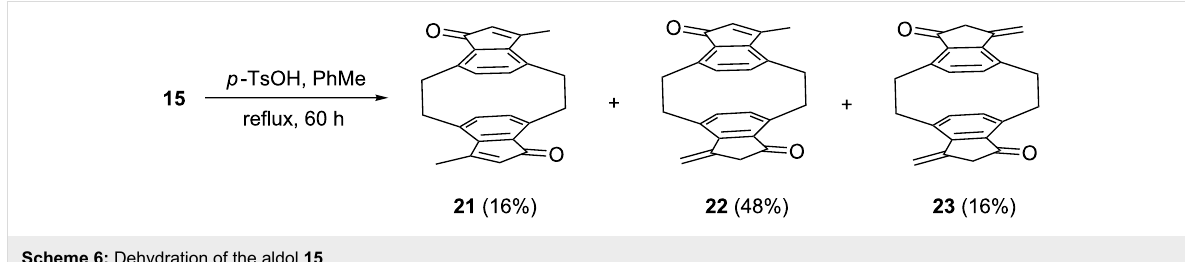
Scheme 6: Dehydration of the aldol 15 .